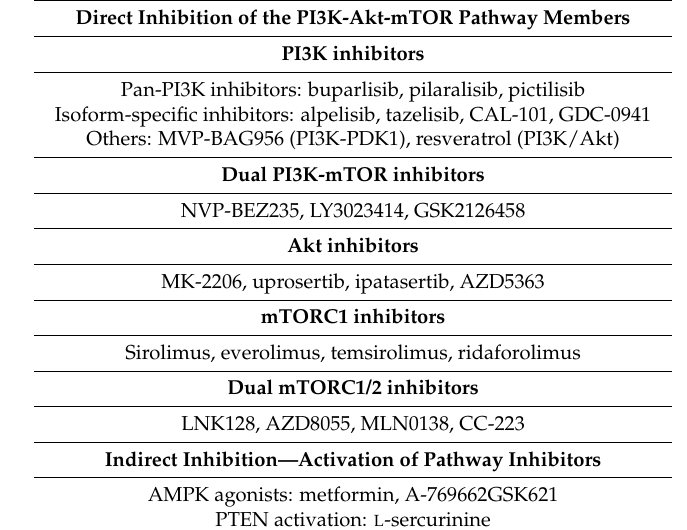
Table 1. Pharmacological targeting of the PI3K-Akt-mTOR—an overview of various pharmacological agents directed against different mediators/regulators of the pathway